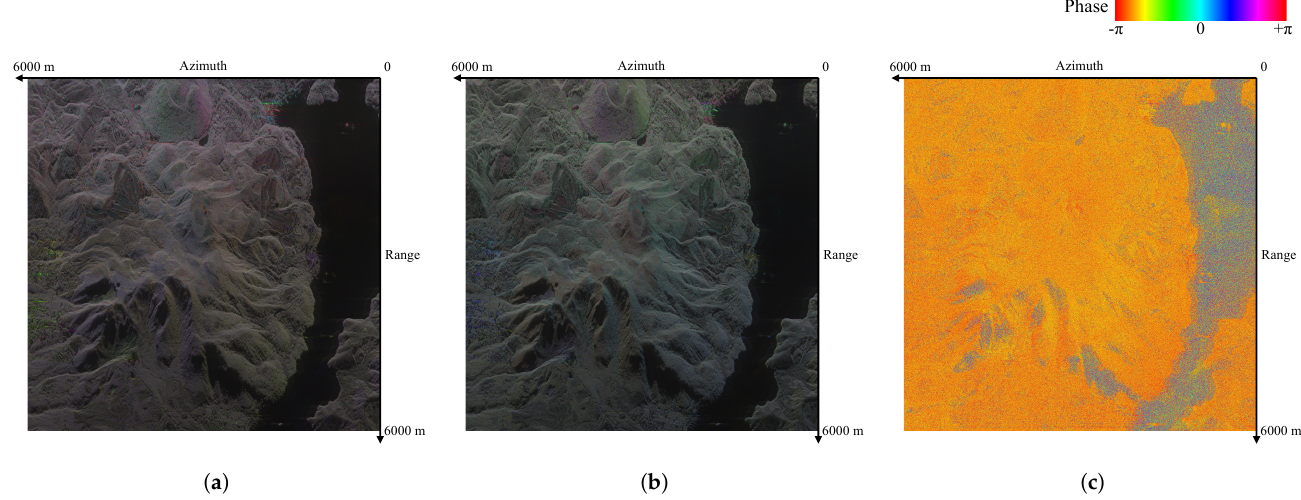
Figure 6. Phase difference of HV and VH around Mount Hakone on 3 December 2015 (Center: N35.218, E139.031). ( a ) MGP_H_HVm. ( b ) MGP_H_VHm. ( c ) Arg ( Z HV Z ∗